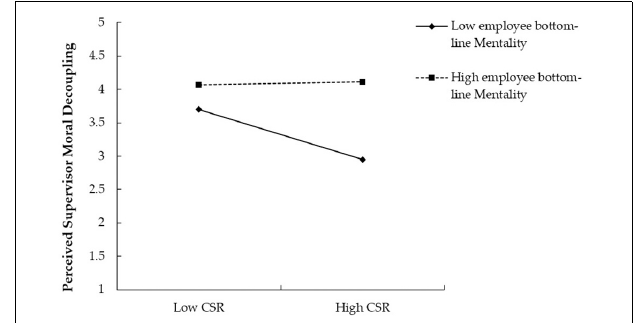
FIGURE 2 | Moderation effects of employee bottom-line mentality on the relationship between CSR and perceived supervisor moral decoupling.